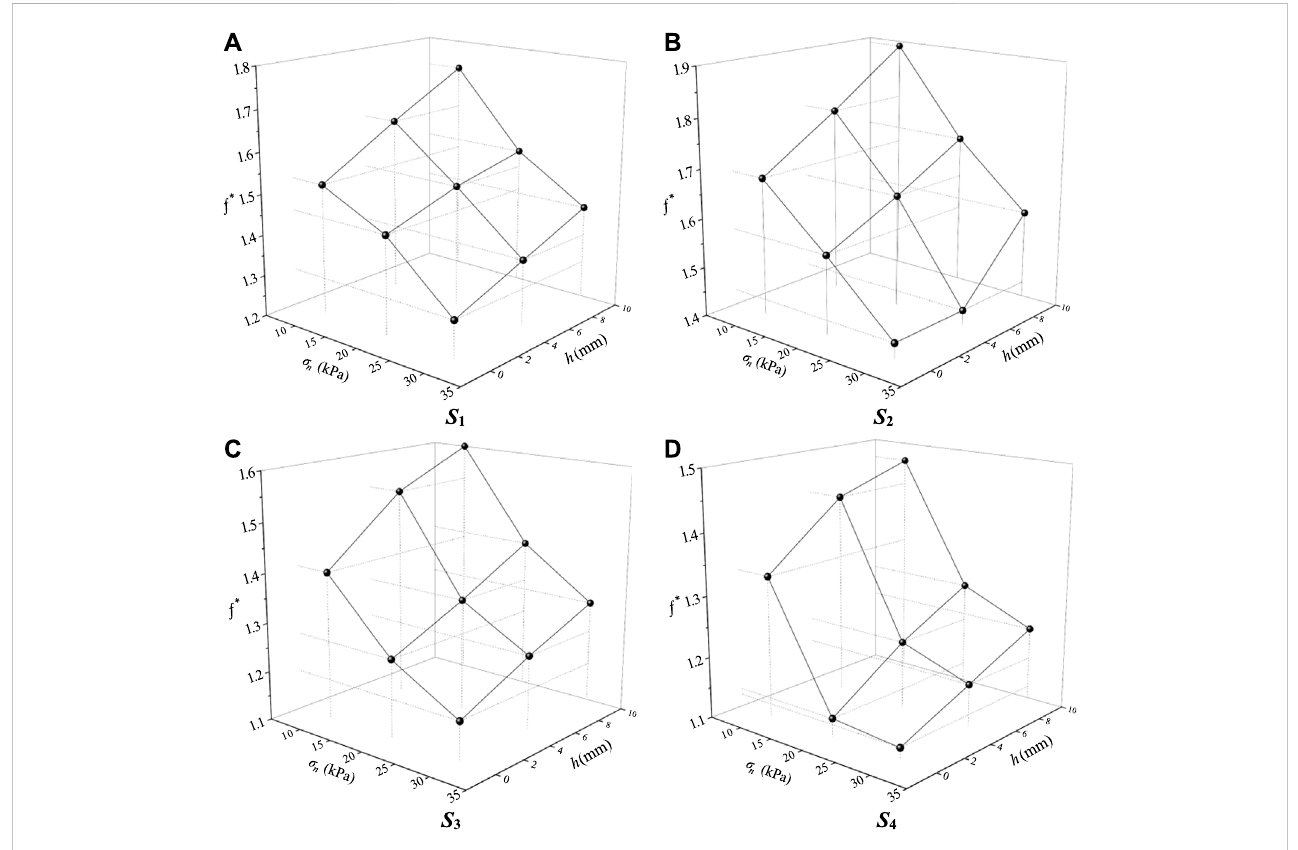
FIGURE 7 f*~ σ n ~h mesh of warp-knitted toothed geogrids.